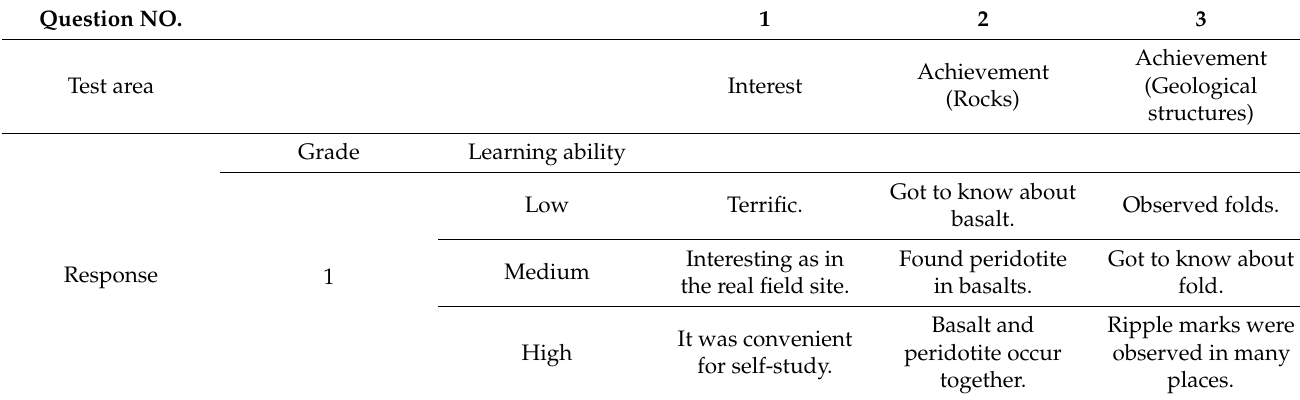
Table 8. Responses obtained in Individual Interviews (Refer to questions in Table 4). Question